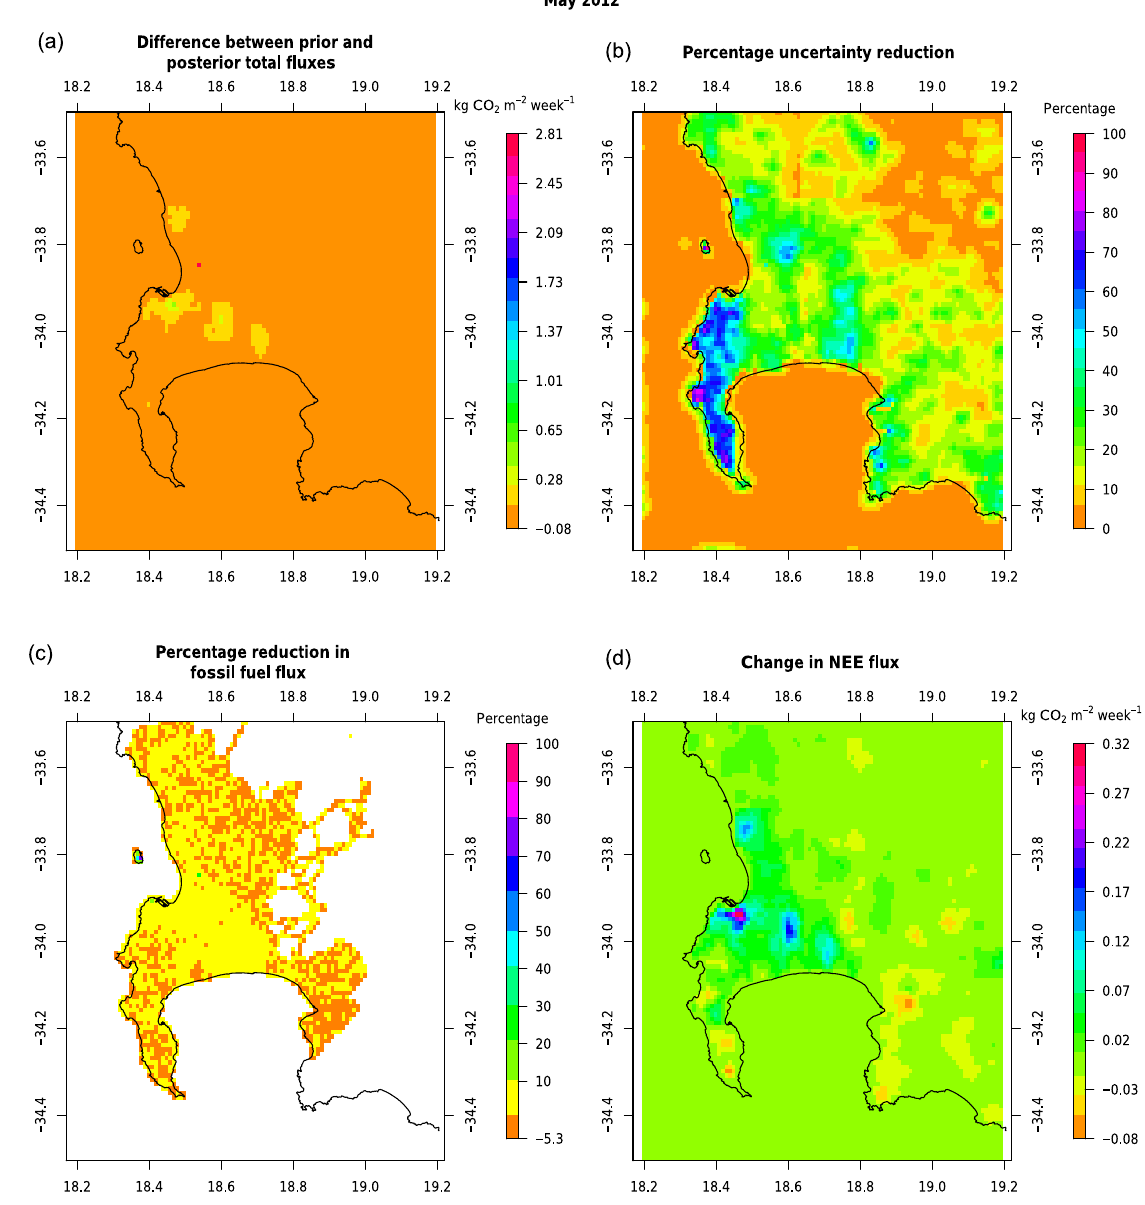
Figure 12. (a) Differences between the prior and posterior total flux estimates (kg CO 2 m − 2 week − 1 ) for May 2012 (prior – posterior). (b) Percentage reduction in the standard deviation of the flux estimate from prior to posterior. (c) Percentage reduction in the fossil fuel flux estimates from prior to posterior. (d) Differences in the biogenic flux estimates between prior and posterior estimates (prior – posterior) (kg CO 2 m − 2 week − 1 ), with negative values indicating posterior CO 2 fluxes were made more positive by the inversion compared with the prior estimates. Extent: between 34.5 and 33 . 5 ◦ S and between 18.2 and 19 . 2 ◦